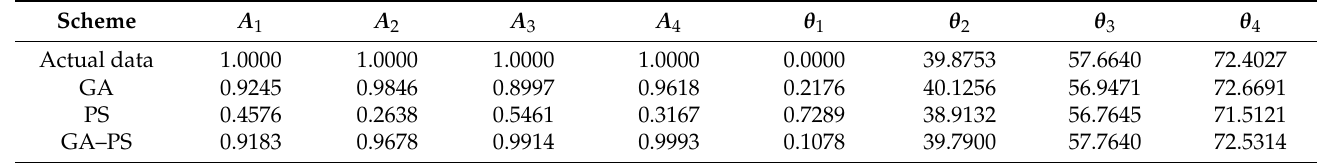
Table 11. Comparison of DOAs achieved using GA, PS, and GA–PS.